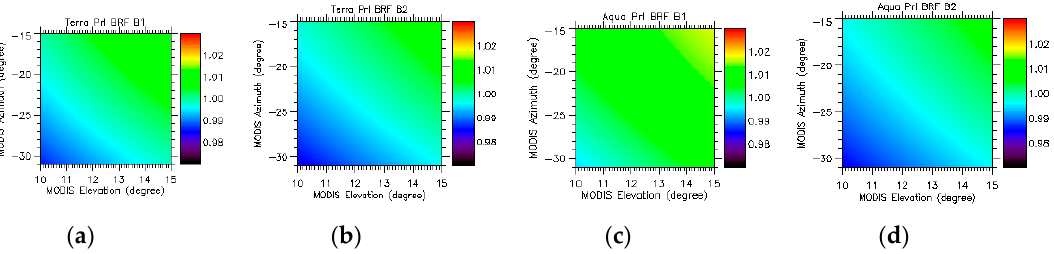
Figure 3. MODIS and VIIRS pre-launch and on-orbit RSB radiance/reflectance calibration traceability .